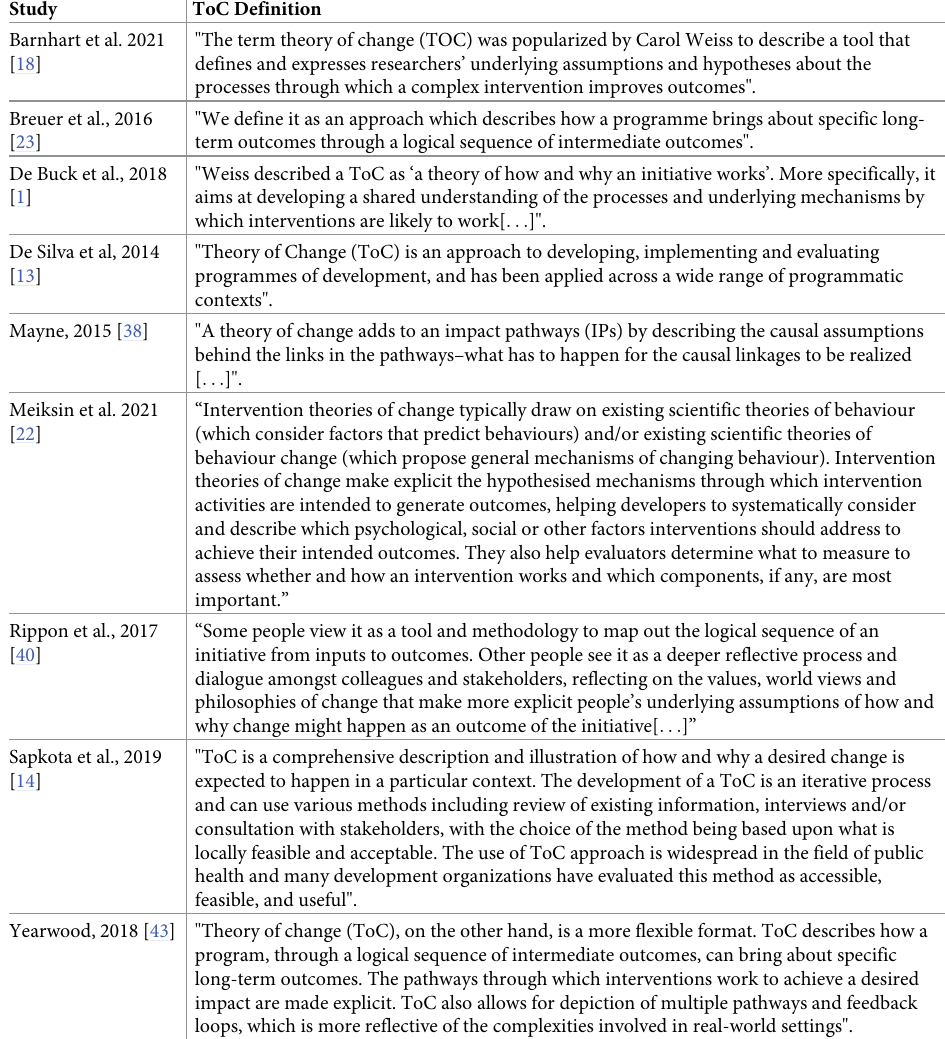
Table 2. Definitions of ToC from the included